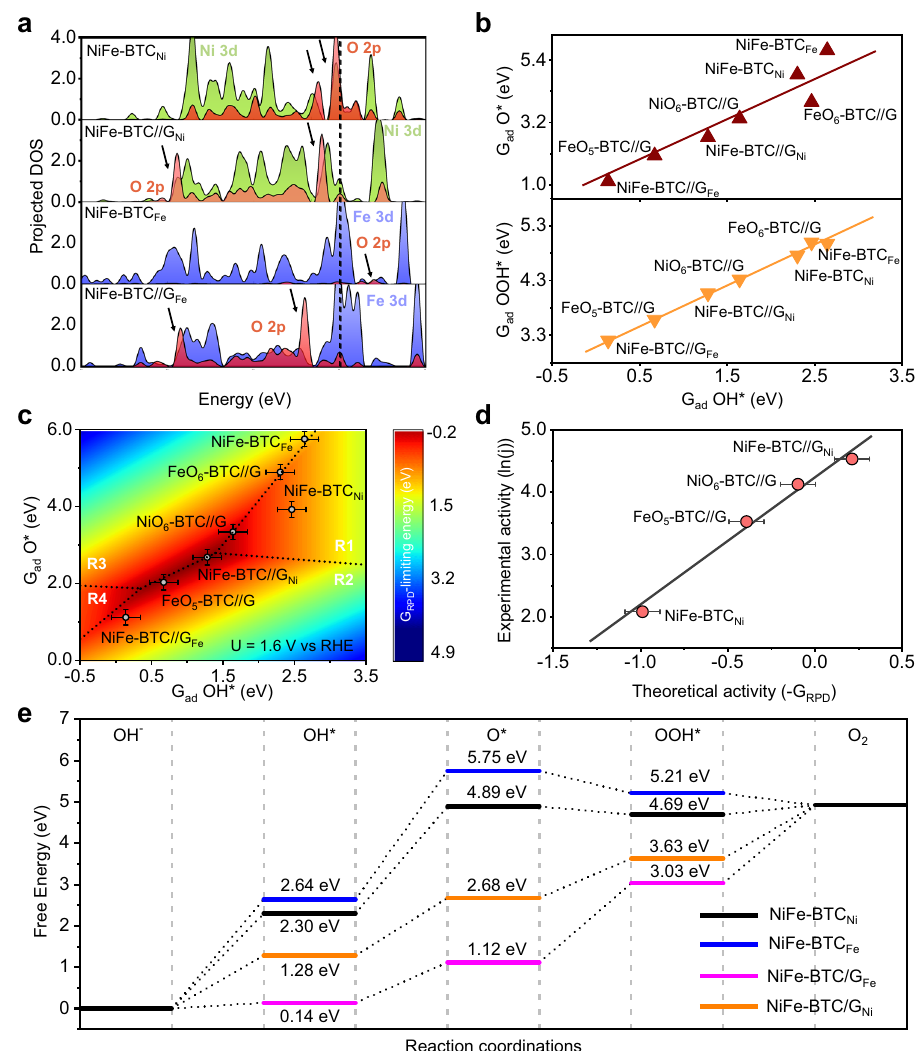
Fig. 4| DFTcalculationsofOERactivity.a PDOSofNi/Fe3d and O2porbitalsfor NiFe-BTC (NiFe-BTC Ni and NiFe-BTC Fe for O binding with Ni and Fe atom) and Con fi nedNiFe-BTC (NiFe-BTC//G Ni and NiFe-BTC//G Fe for O bindingwith Ni and Fe atom in the con fi nement environment). b Linear scaling relationship between adsorption energies of O*/OOH* vs. OH*. All the energies have been corrected to free energy with also solvent effect considered (see all optimized structures in Supplementary Fig. 43). c Two-dimensional activity map with O* and OH* as two independent descriptors. The dotted lines separate the reaction phases with dif- ferent limiting steps as R1, R2, R3 and R4 (refer to Supplementary Equations 4 – 7).